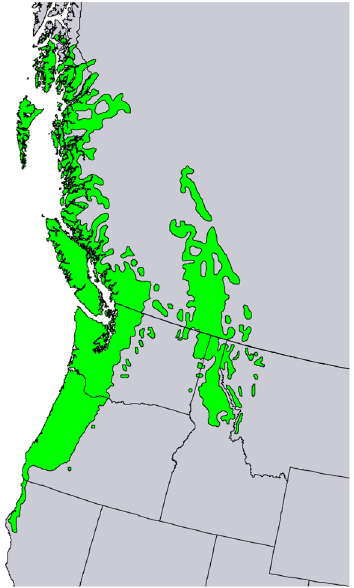
Figure 9. Native range of Thuja plicata [6].